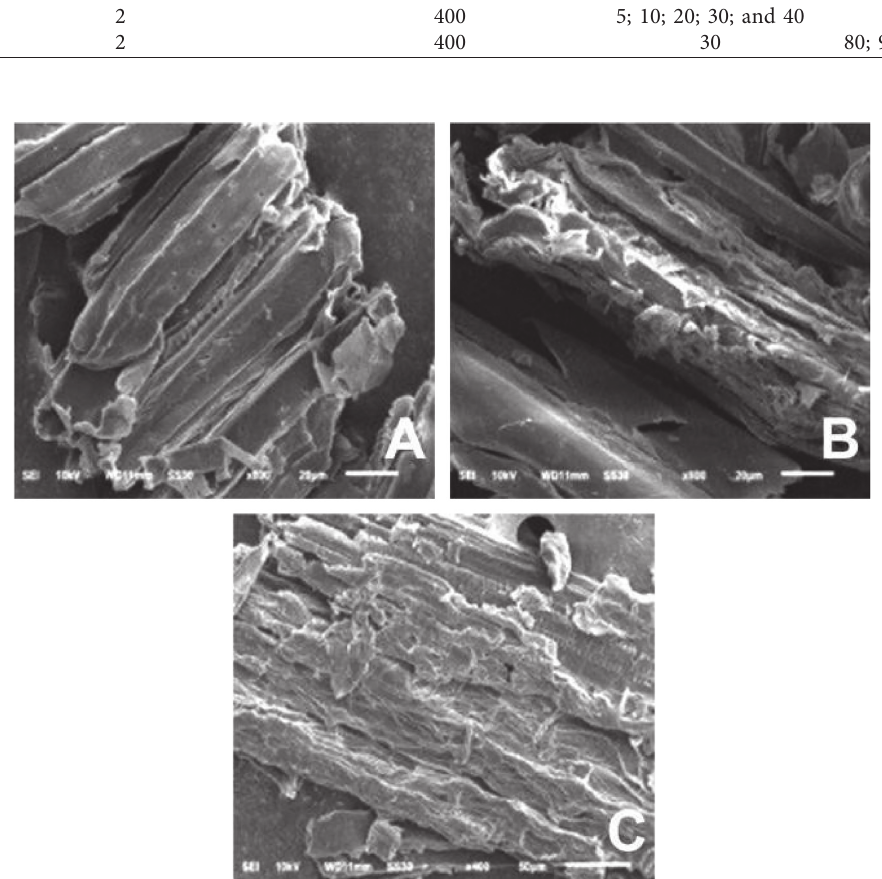
Figure 1: Morphology of the elephant grass powder: (a) before treatment; (b) after delignification process; and (c) after the delignification process followed by acid